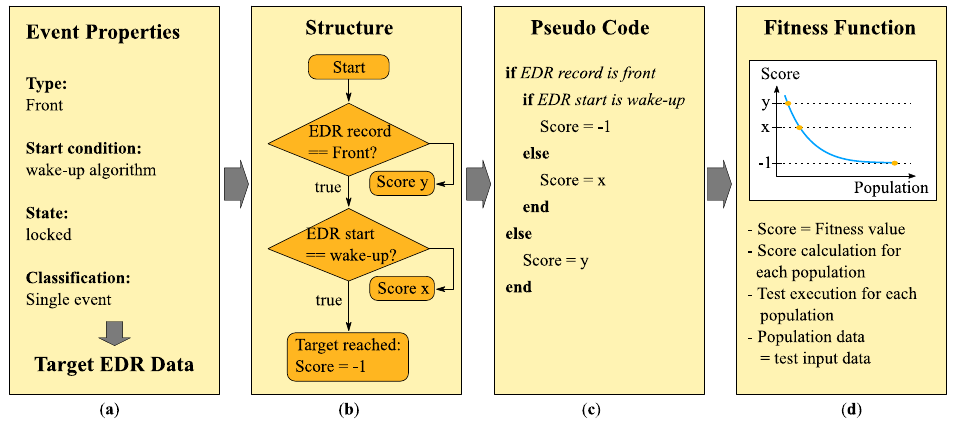
Figure 11. Process of fitness value calculation. ( a ) Defining the target EDR data based on event properties; ( b ) structural graph of the fitness function; ( c ) pseudo-code of the fitness function; ( d ) visualization of the fitness function calculation per population.